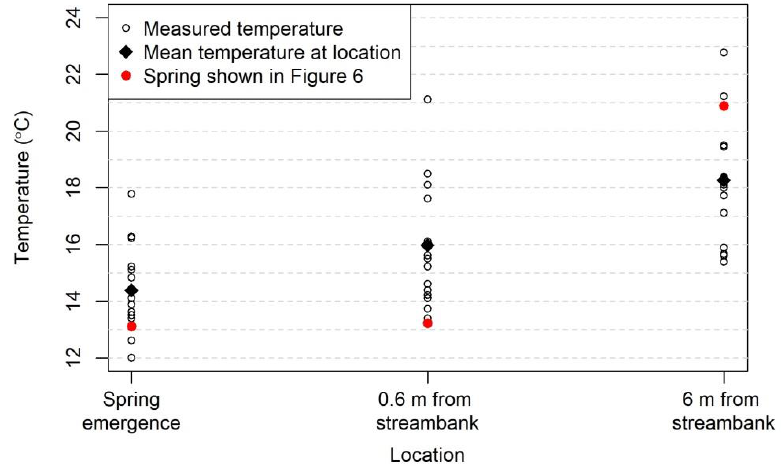
Figure 7. Water temperature at three locations measured at each of 20 distinct springs.